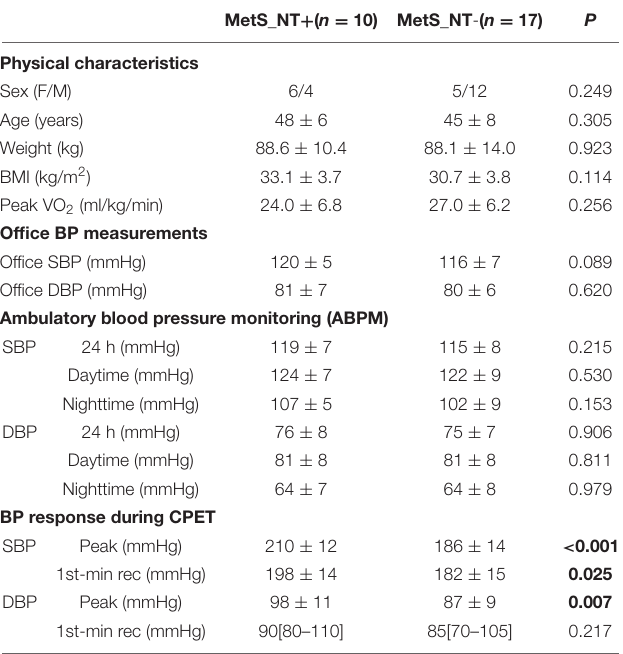
TABLE 3 | Physical characteristics, office BP, BP of the ABPM recordings, and BP response during CPET in normotensive MetS with (MetS_NT + ) and without (MetS_NT − ) exaggerated exercise BP response (EEBP) during maximal CPET.